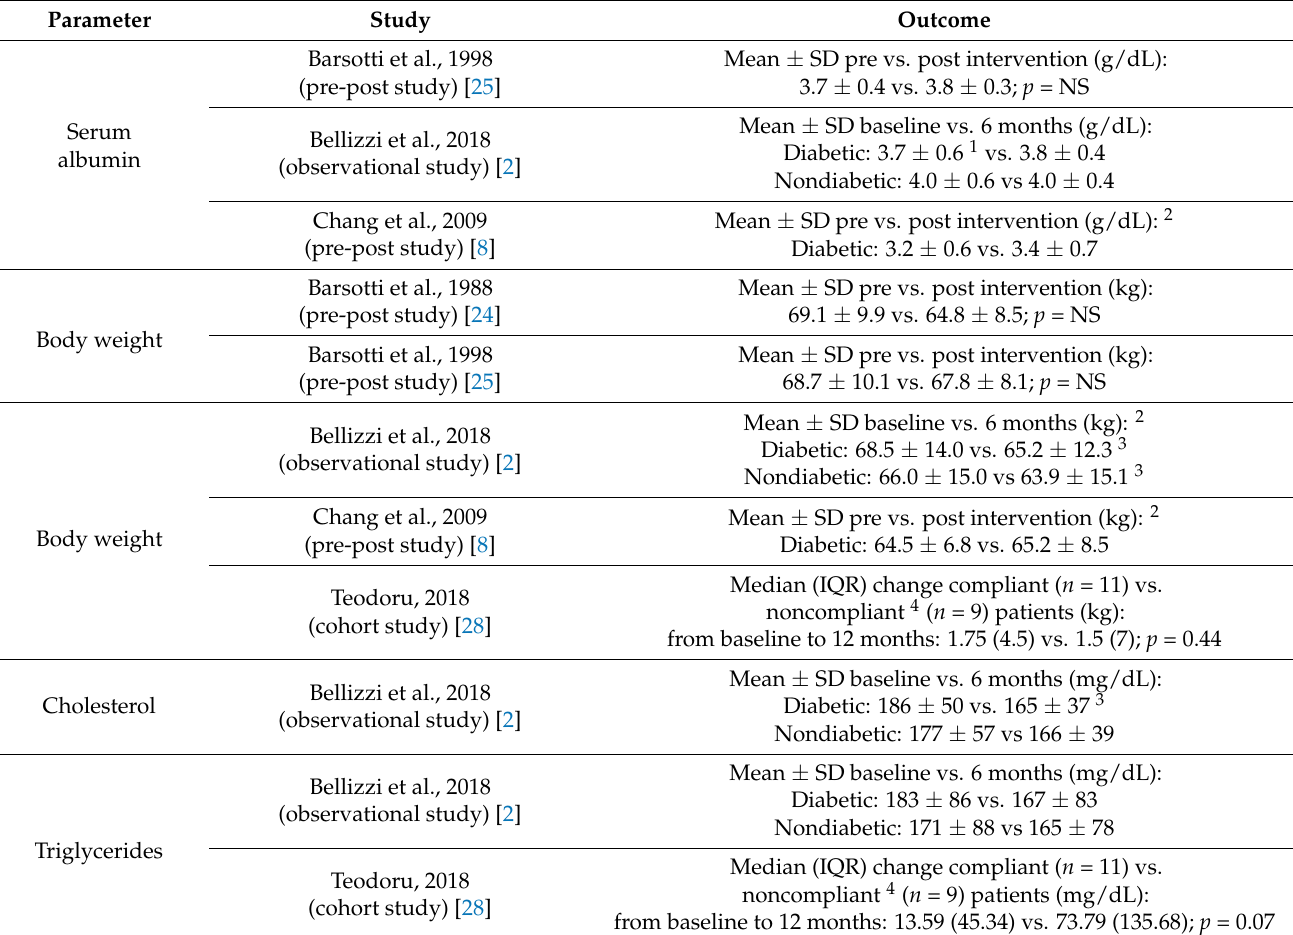
Table 5. Results from studies that examined nutritional